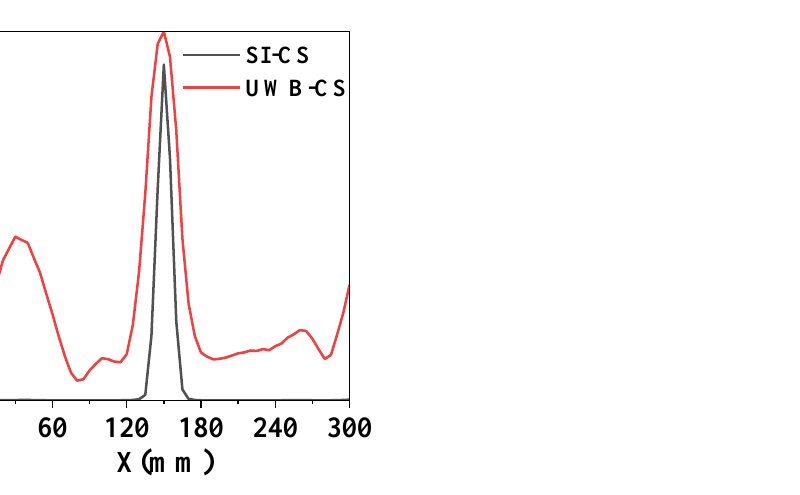
Figure 6. The trend of the peak in the lateral direction at the PIM source location for the UWB-CS method and the SI-CS method.